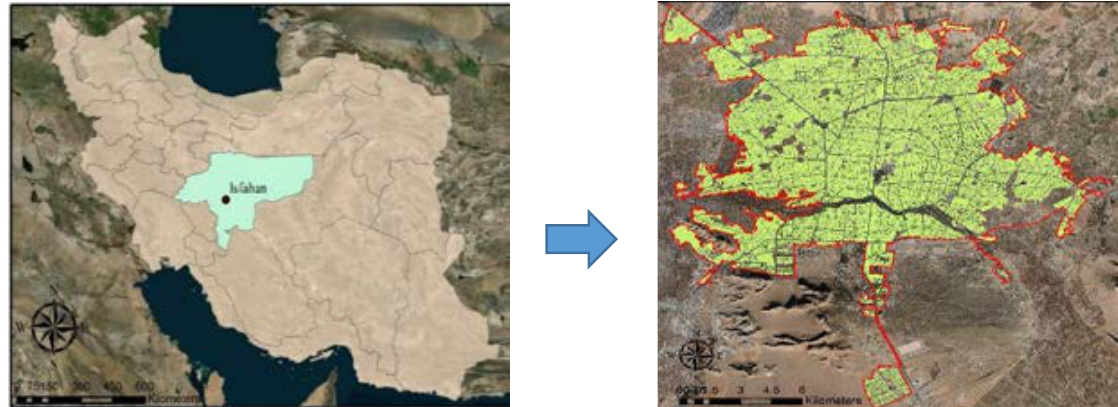
Fig. 1: the location of Isfahan metropolis in Isfahan province, Iran (a); Boundary and urban blocks of Isfahan Metropolis located in Isfahan province, Iran (b)